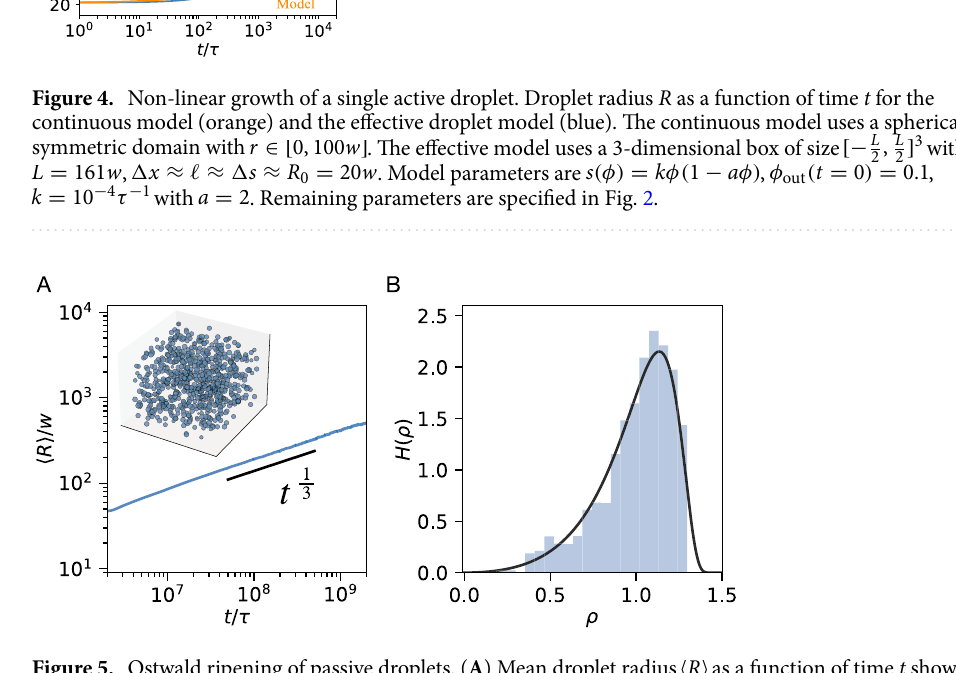
Figure 5. Ostwald ripening of passive droplets. ( A ) Mean droplet radius R t 1 / 3 . Inset shows snapshot at t expected 43,44 scaling � � ∝ 2 10 8 τ compared to the expected universal distribution (black) 43,44 . ( A , B ) R / R radius ρ at t � � = × = Simulations were carried out in a 3-dimensional periodic cubic domain of size ℓ L and a single shell sector to approach the mean field solution. 10 5 droplets were initialized with used � x ≈ ≈ radii chosen uniformly in [9.5 w , 10.5 w ] in an initial background φ out ( t specified in Fig.